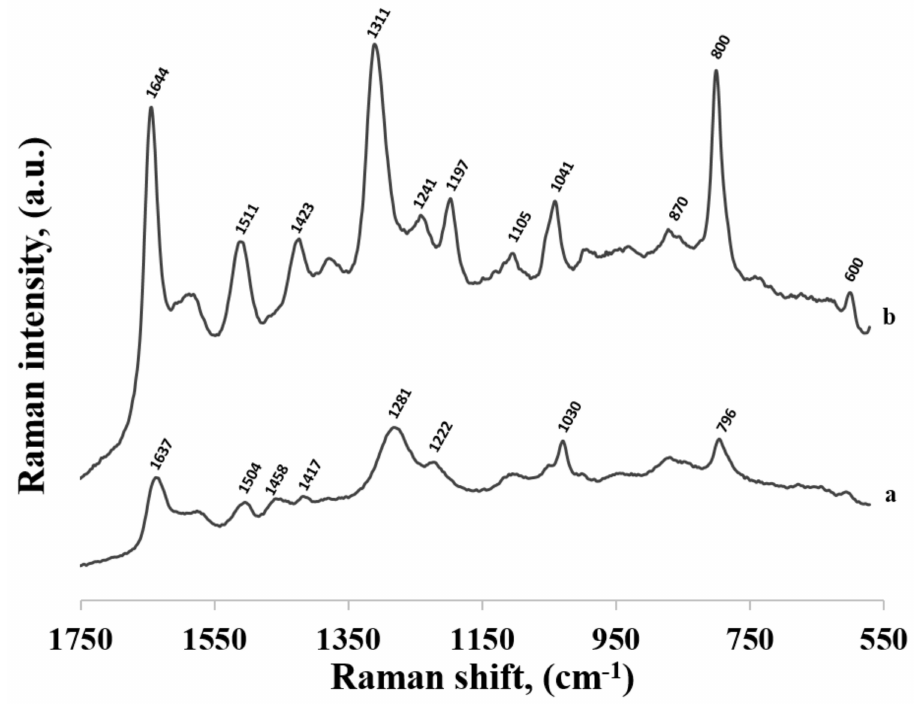
Figure 6. SERS spectra of: (a) thiolated cytosine mononucleotide and (b) cytosine adsorbed on gold nanoparticles.